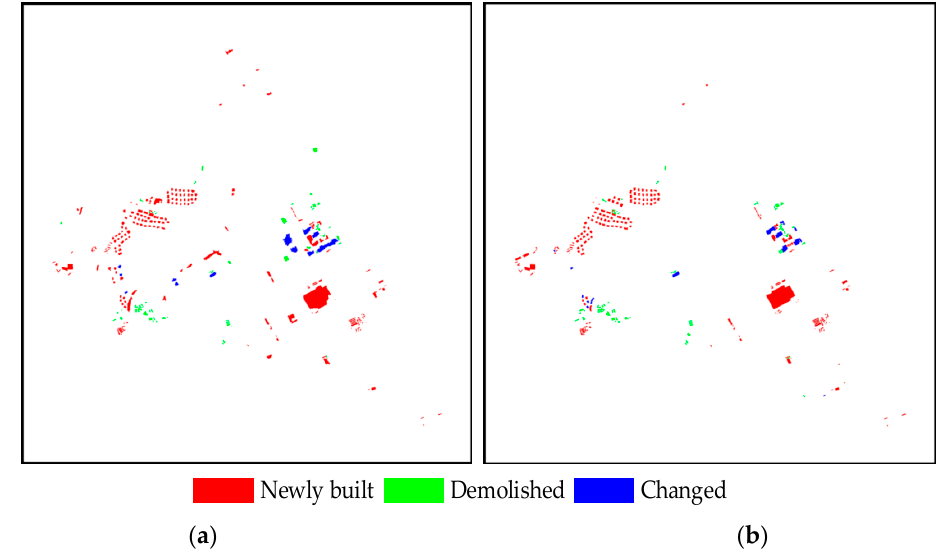
Figure 13. Results of building change detection using the ( a ) proposed method and ( b ) ground truth on Dataset 1.